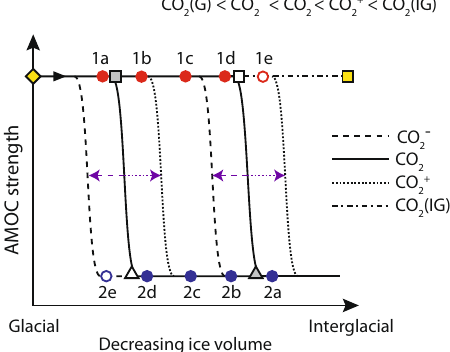
Fig. 5 Moveable window of AMOC bistability. Schematic stability diagram for AMOC strength as a function of continental ice volume 57 for different levels of atmospheric CO 2 45 (CO 2 (Glacial) < CO 2 − < CO 2 < CO 2 + < CO 2 (Interglacial) ). Varying atmospheric CO 2 leads to structural changes in AMOC stability with respect to ice volume (and vice versa) e.g. increasing CO 2 pushes the window of bistability with respect to ice volume to the right. Yellow diamond represents monostable strong glacial mode of AMOC (a function of large ice sheets) while yellow square represents monostable strong interglacial mode of AMOC (a function of high CO 2 ). Other symbols and corresponding letters are referred to in the